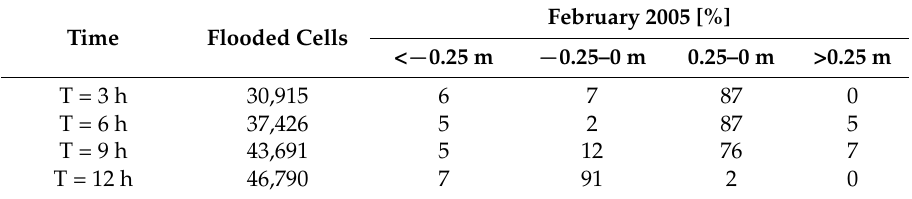
Table 8. Percentage of inundated cells at the advective event in February 2005.